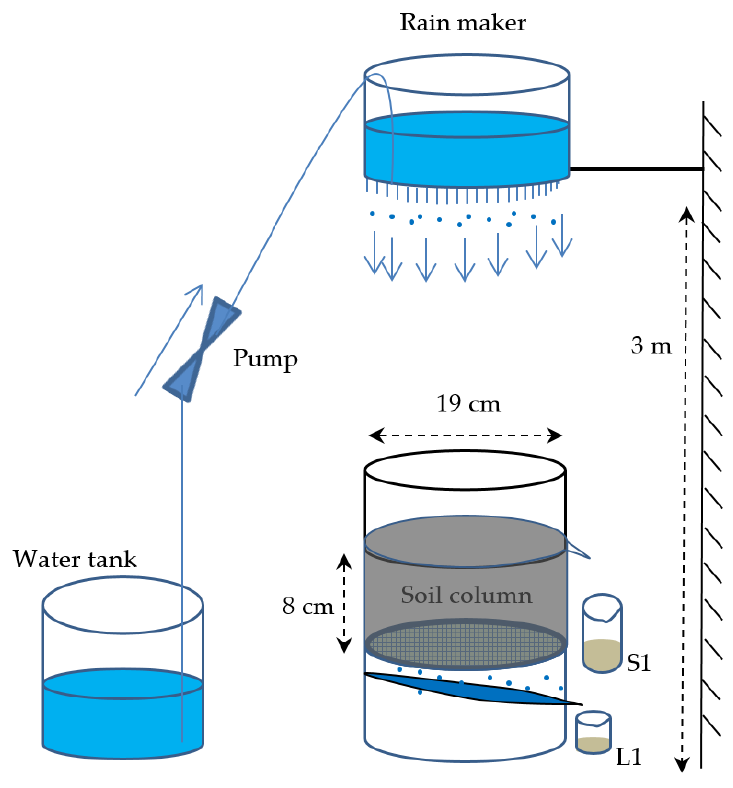
Figure 2. Schematic of the simulated-rainfall experimental